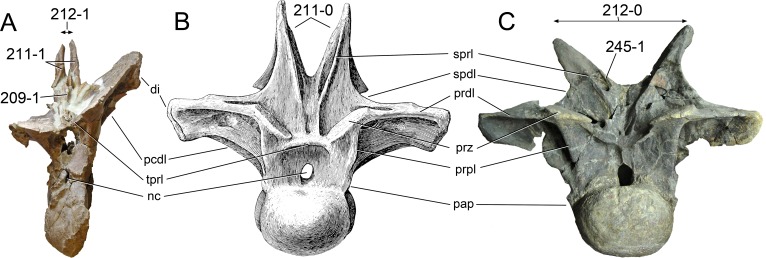
Flagellicaudatan anterior dorsal vertebrae.Anterior dorsal vertebrae of Suuwassea emilieae ANS 21122 (A), Brontosaurus parvus UW 15556 (B; modified from Gilmore, 1936), and Apatosaurus ajax YPM 1860 (C) in anterior view. Note the prespinal lamina (A and C; C209-1), the diverging (B; C211-0) or parallel neural spines (A; C211-1), the wide (C; C212-0) or narrow (A; C212-1) distance between the spine tops, and the ridge on the medial side of the neural spine (C; C245-1). Abb.: di, diapophysis; nc, neural canal; pap, parapophysis; pcdl, posterior centrodiapophyseal lamina; prdl, prezygodiapophyseal lamina; prpl, prezygoparapophyseal lamina; prz, prezygapophysis; sprl, spinoprezygapophyseal lamina; tprl, interprezygapophyseal lamina. Scaled to same anterior condyle height.